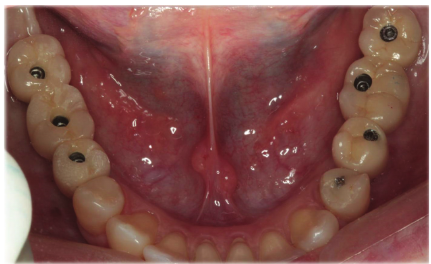
Figure 22: Clinical aspect of prosthetic rehabilitation.